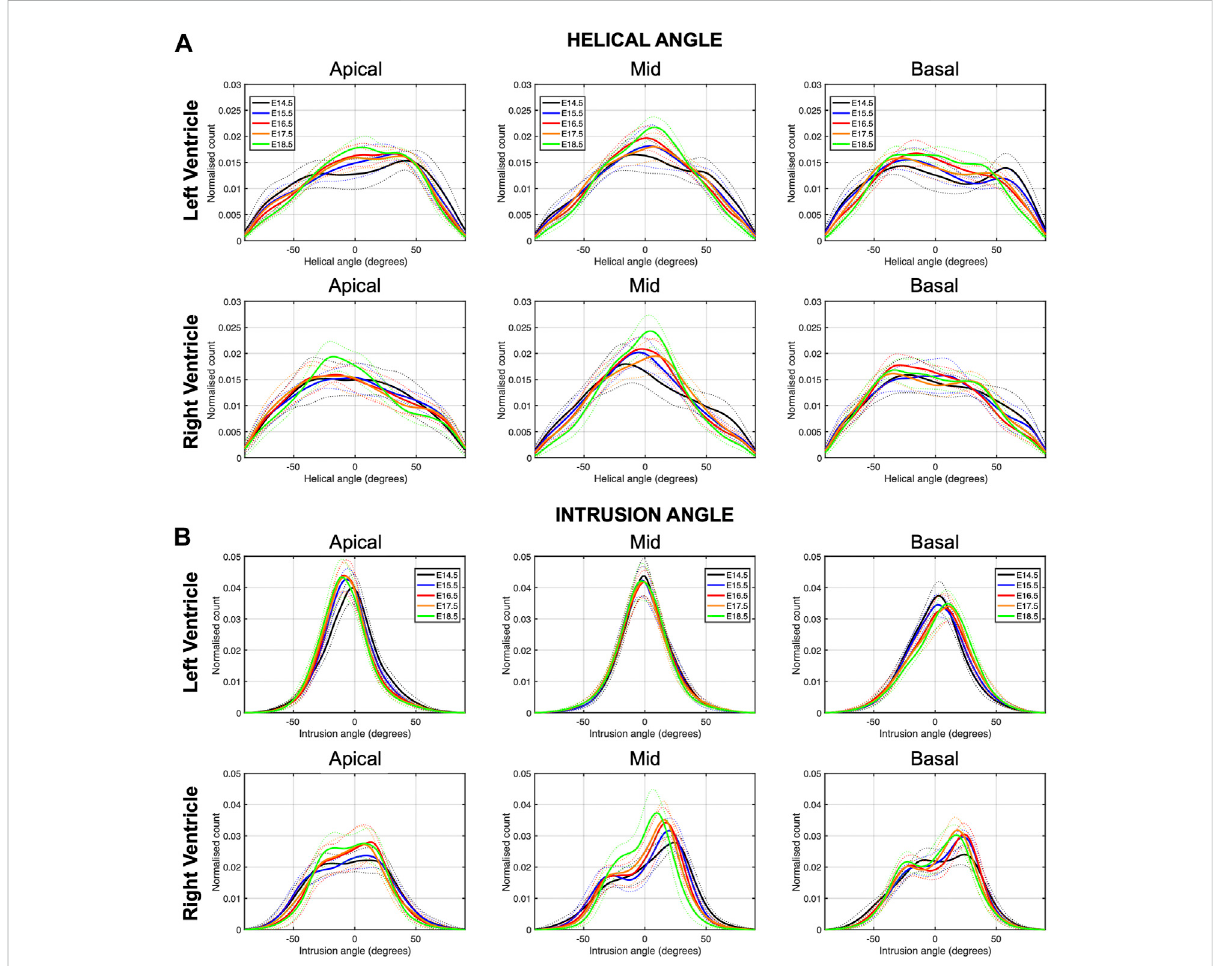
FIGURE 3 Histograms of (A) helical (HA) and (B) intrusion angle (IA) across the apical, mid-ventricular and basal LV and RV of murine hearts at E14.5, E15.5, E16.5, E17.5 and E18.5 days of development. Solid lines: age-group mean. Dotted lines: ± standard deviation.